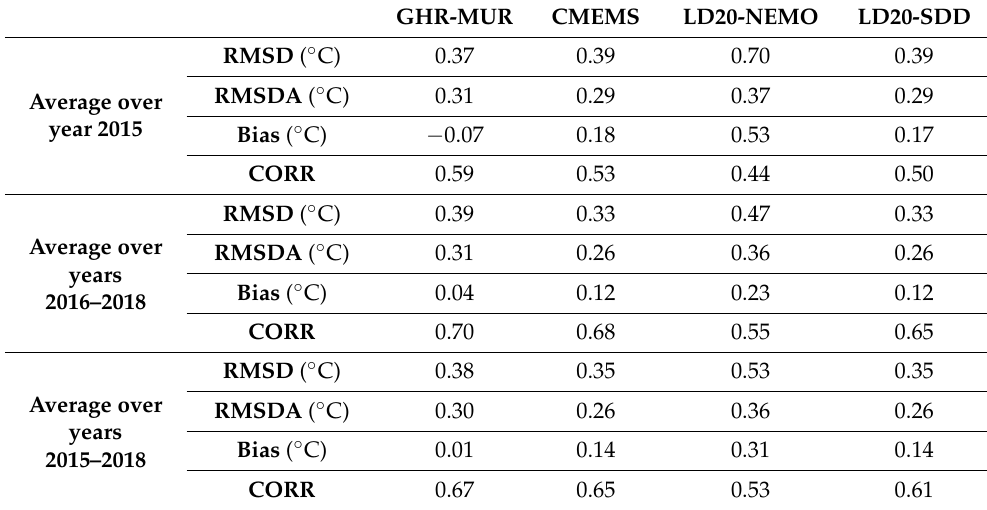
Table 1. Time-averaged RMSD, RMSDA, Bias and CORR, for GHR-MUR, CMEMS, LD20-NEMO and LD20-SDD, with OSTIA SST taken as